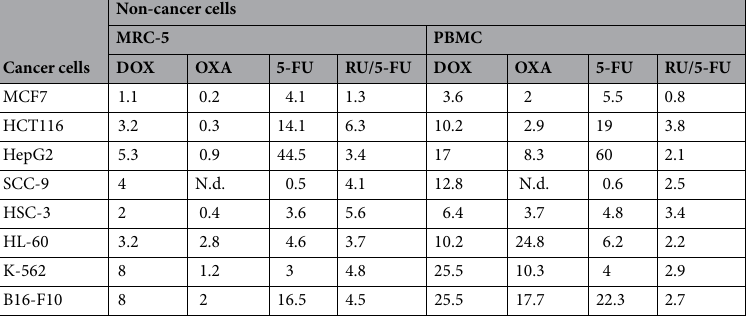
Table 2. Selectivity index of the complex [Ru(5-FU)(PPh 3 ) 2 (bipy)]PF 6 (RU/5-FU). Data are presented the selectivity index (SI) calculated using the following formula: SI = IC 50 [non-cancer cells]/IC 50